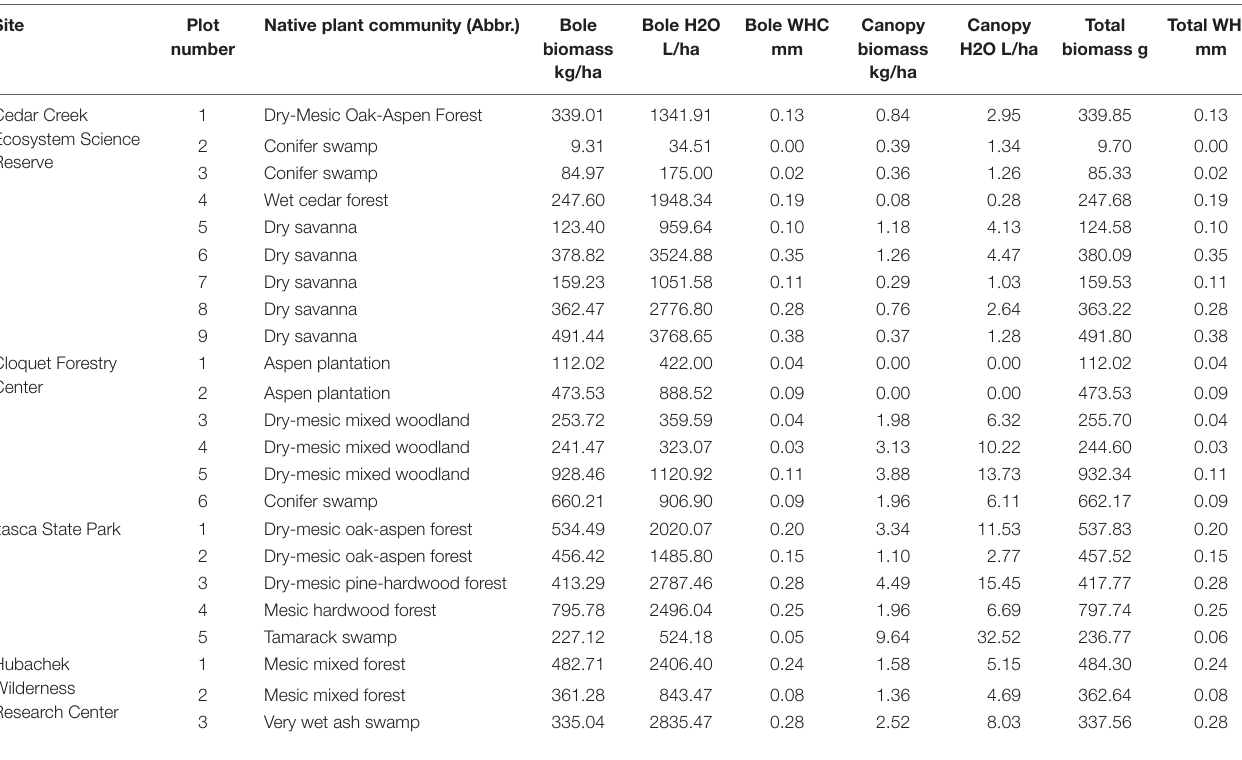
TABLE 3 | Biomass and potential water-holding capacity (as both L/ha and mm depth equivalent) of bole, canopy and total epiphyte communities at each study site. Site Plot Native plant community number